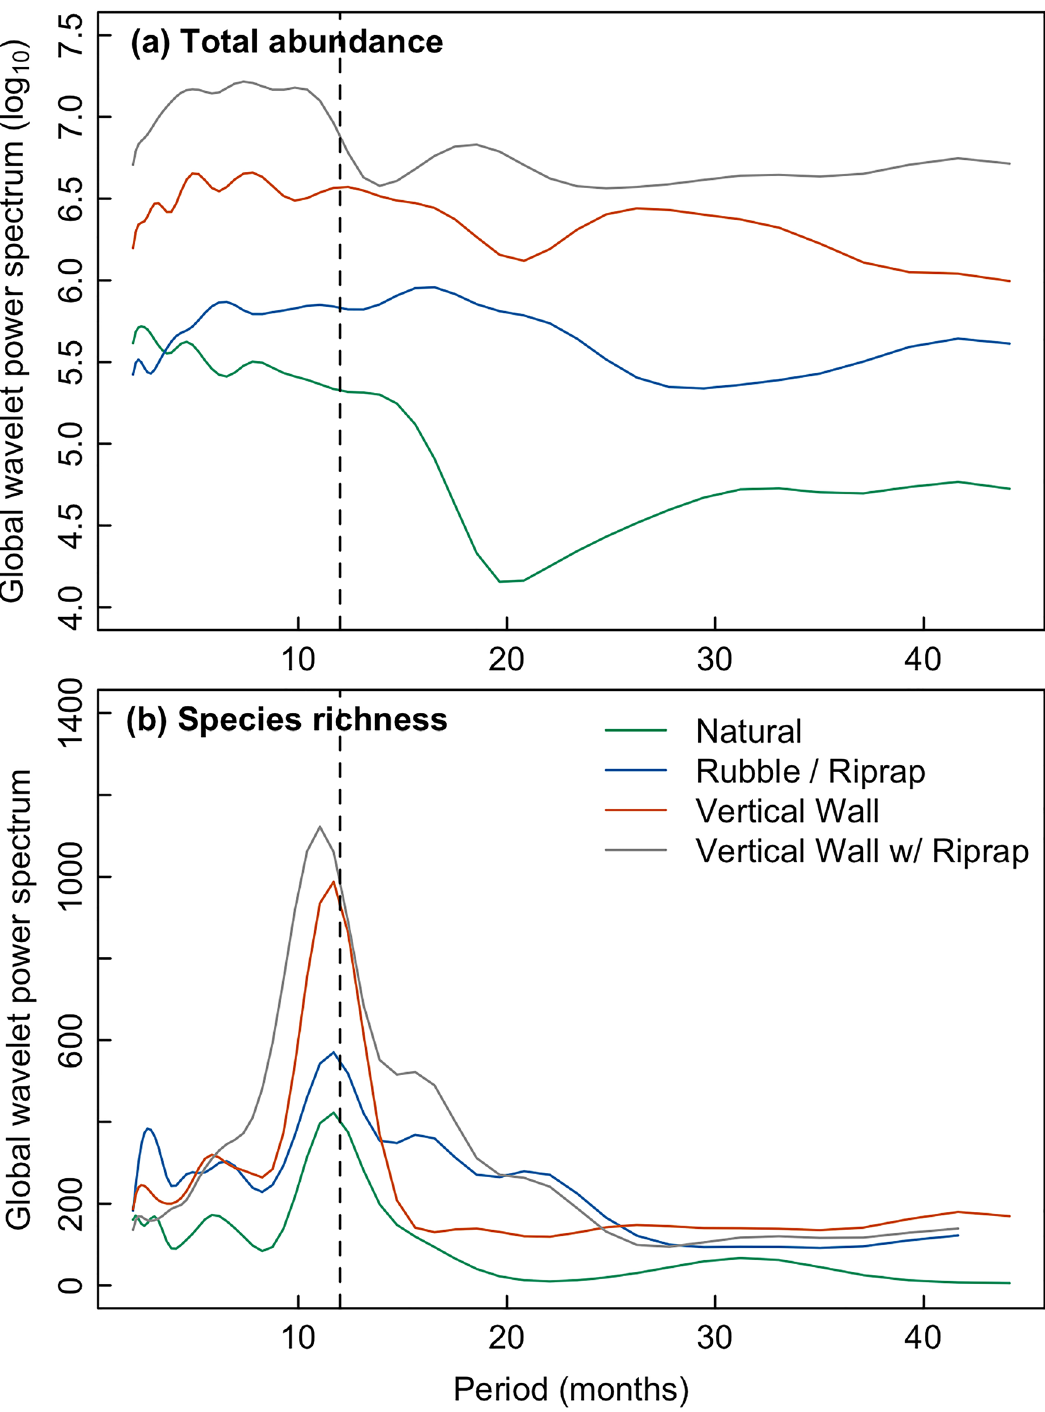
Fig 4. Global wavelet power spectrum of monthly average abundance and species richness by shoreline type. The global wavelet power represents the time-averaged variance of a signal (i.e., total abundance in panel [a] and species richness in panel [b]) at each period. For average abundance, wavelet analysis was performed for each species to obtain the global wavelet power spectrum. The global wavelet power spectrum was then averages across all species.